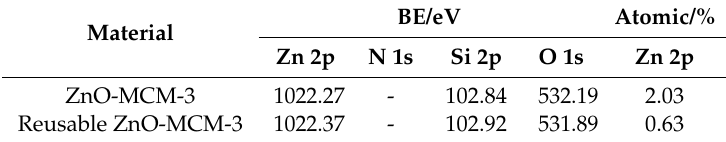
Table 6. Binding energy and atomic of ZnO-MCM-3 after six photodegradation cycles of